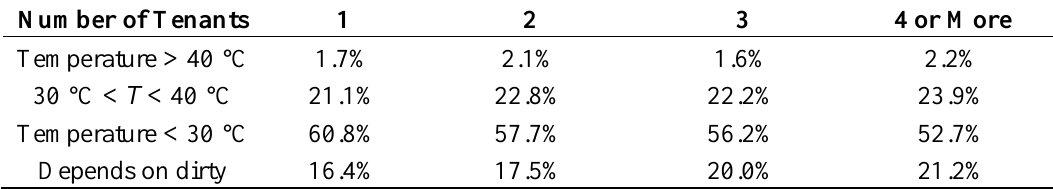
Table 13. Water temperature in Washing Machines in 2008 (Spain)